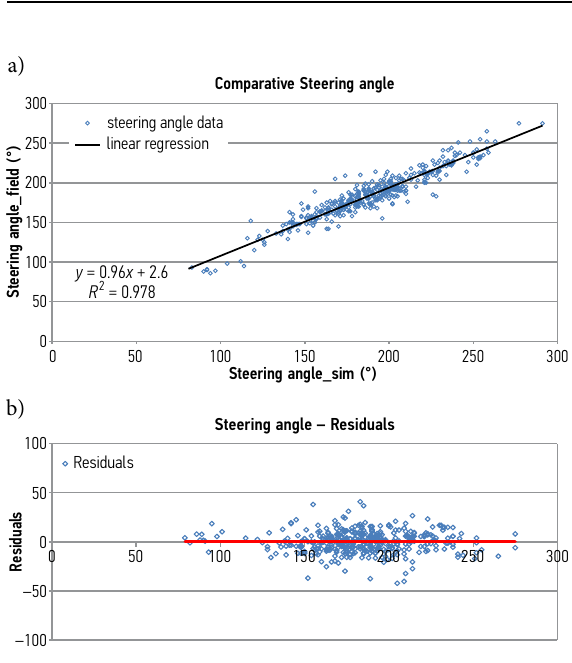
Fig. 12. Linear regression of steering angle data (a) trend of residuals (b)